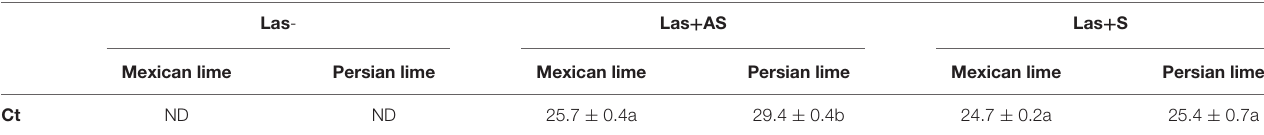
Results are expressed as mean + SE (n = 3). For each given datum, different letters indicate a statistical difference between genotypes (one-way ANOVA followed by Tukey’s post hoc test, P ≤ 0.05).